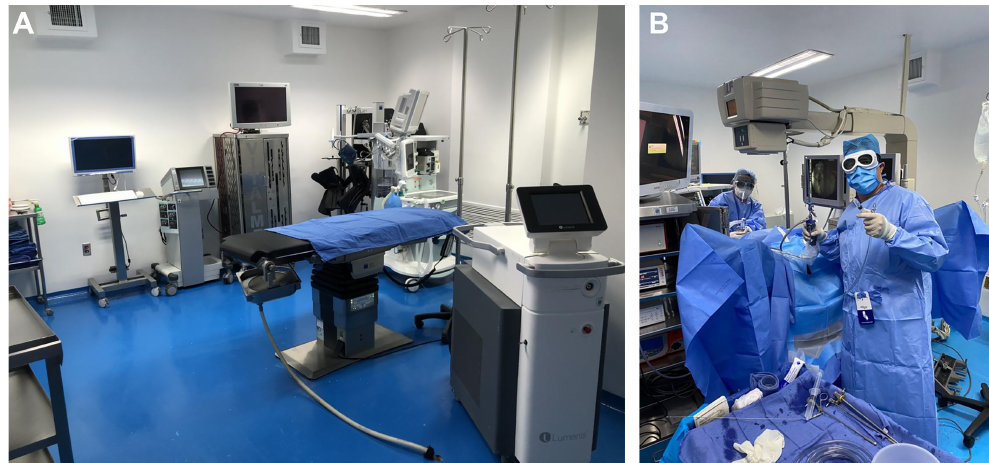
Figure 2 A and B - Intraoperative Management Hospital Central Militar,